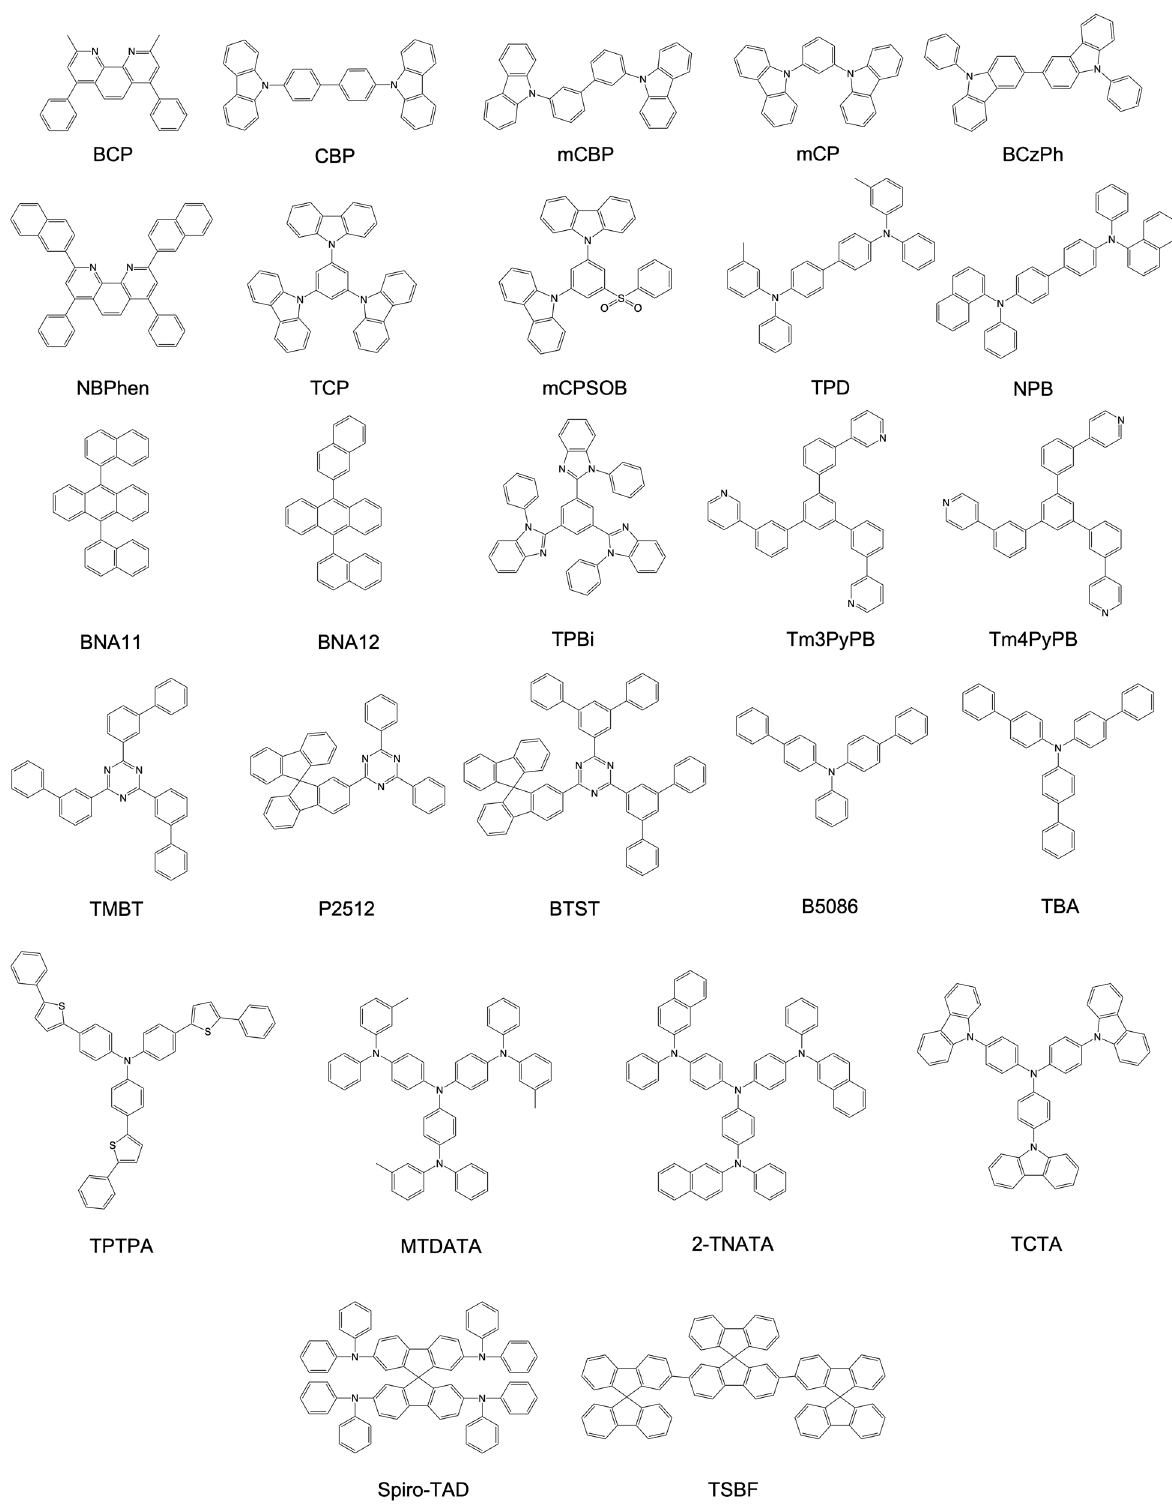
Fig. 1 Molecular structures of organic molecular solids. Chemical structures of 26 OLED host materials and charge transport materials investigated in this variation, we show T g calculated using four fi tting ranges for Region I (A, B) and Region III (C, D) in Fig. 2c. For BCP this leads to variations from 51.2 °C to 147.7 °C, depending on the fi tting ranges.